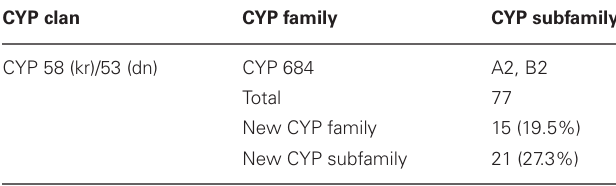
Table 2 | Cytochrome P450 monooxygenase genes (CYP) in B. bassiana